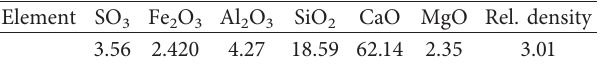
Table 3: The main chemical compositions of the cement used